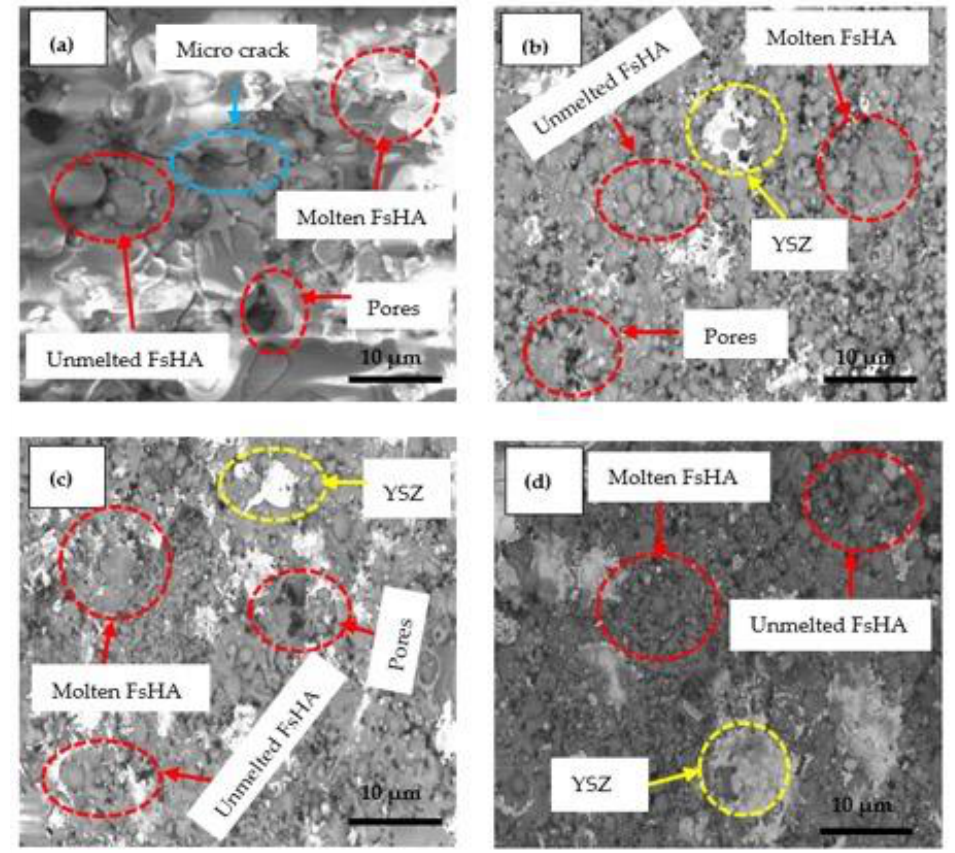
Figure 6. SEM micrographs of FsHA with ( a ) 0 wt.% YSZ, ( b ) 10 wt.% YSZ, ( c ) 15 wt.% YSZ, and ( d ) 20 wt.% YSZ coatings on the Ti – 6Al – 4V alloy substrate.